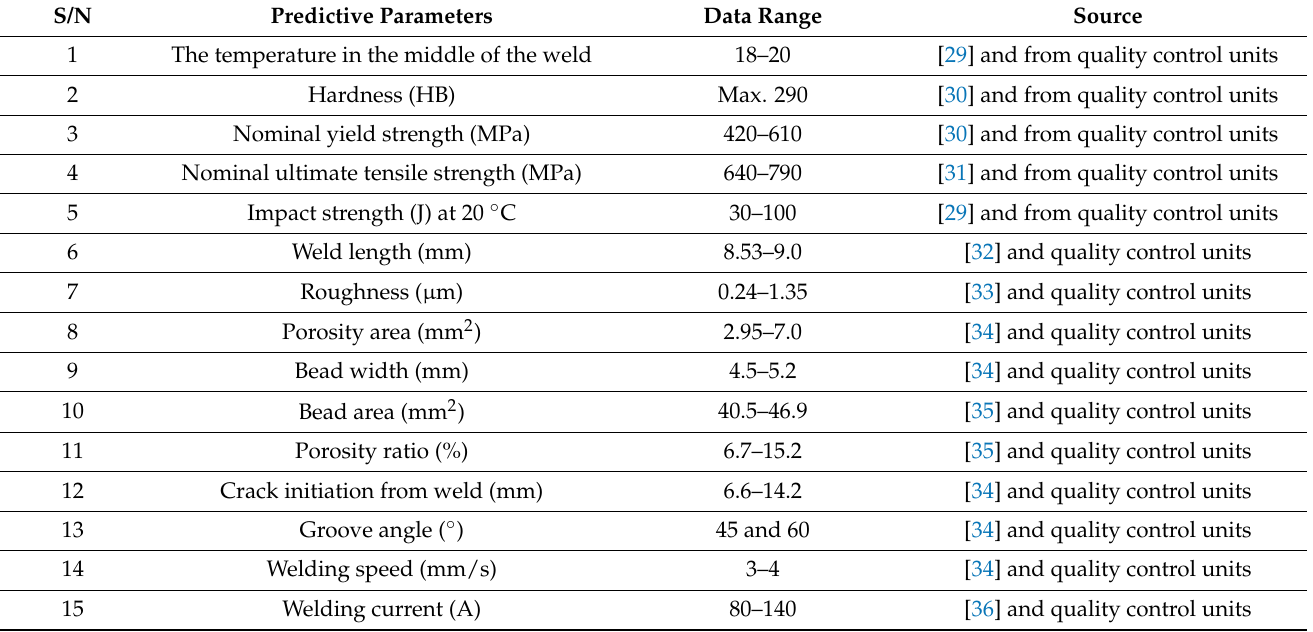
Table 1. Experimental data for the intelligent